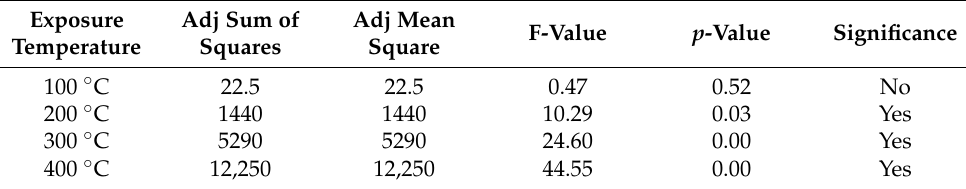
Table 8. Analysis of variance for exposure